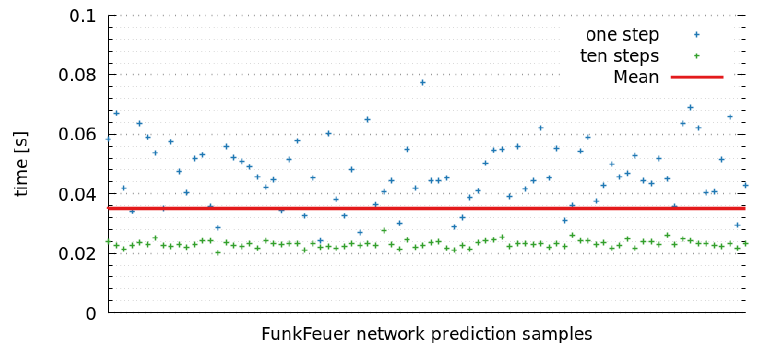
Figure 17. Execution time for one prediction with a preload model. One step means just the time of the next prediction. Ten steps means the average of ten subsequent predictions.